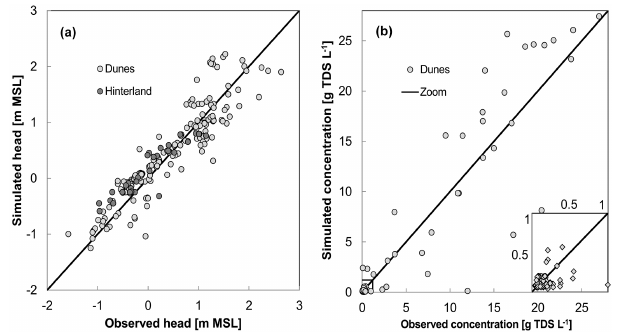
Figure 7. Comparison of observed and simulated heads (a) and con- centration (b) .